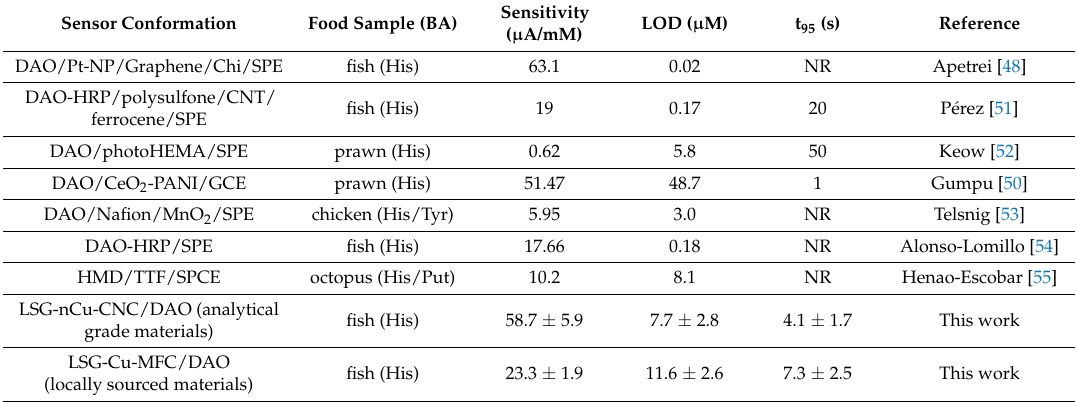
Table 2. Average performance characteristics of enzymatic biosensors for biogenic amines determination. Sensor Conformation Food Sample